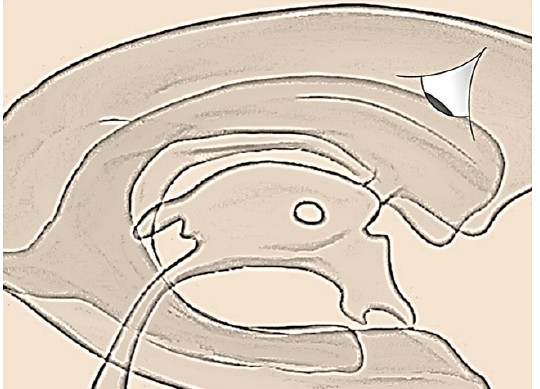
Fig. 5. Direction of the endoscopic viewing angle for foramen of Monro region.